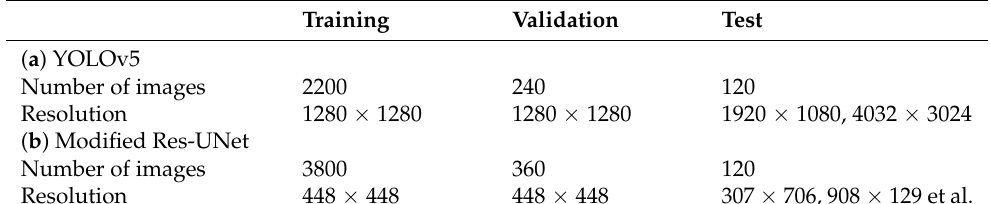
Table 1. Image dataset for crack detection and segmentation.